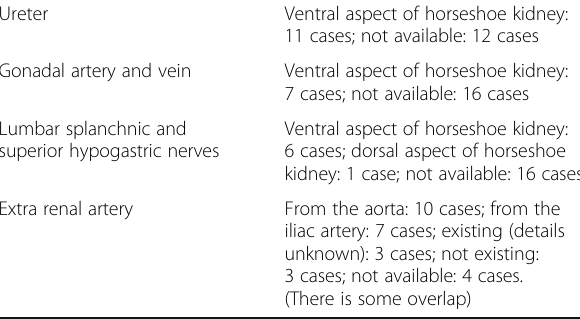
Table 1 Summary of the positions of the anatomical structures in patients undergoing surgery for colon cancer associated